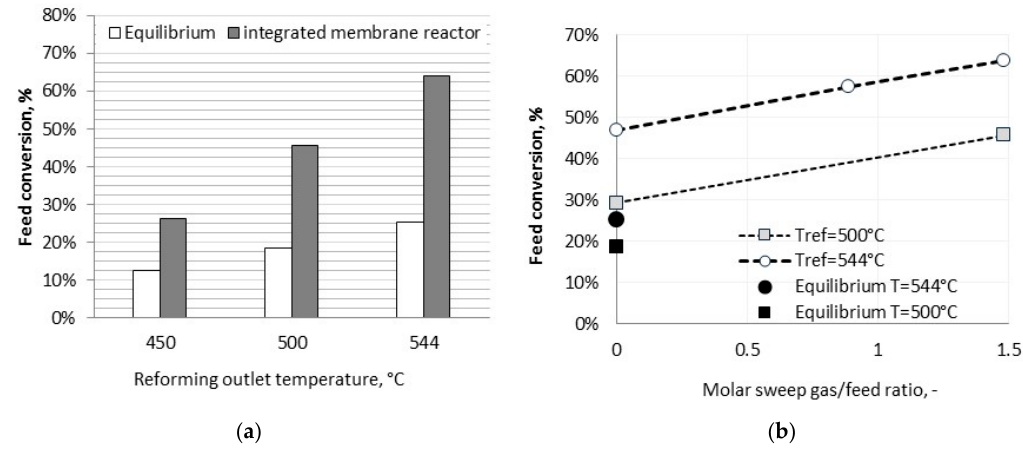
Figure 6. ( a) Feed conversion at different reforming outlet temperatures (P = 9 barg, S/C = 3 mol and ( b ) Effect of the sweep gas on the integrated membrane reforming plant (P = 9 barg, S/C = 3 mol).